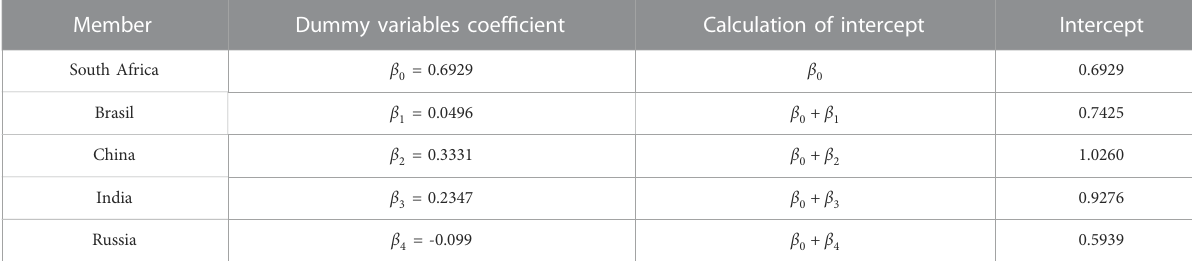
TABLE 4 Intercept calculation for each member of